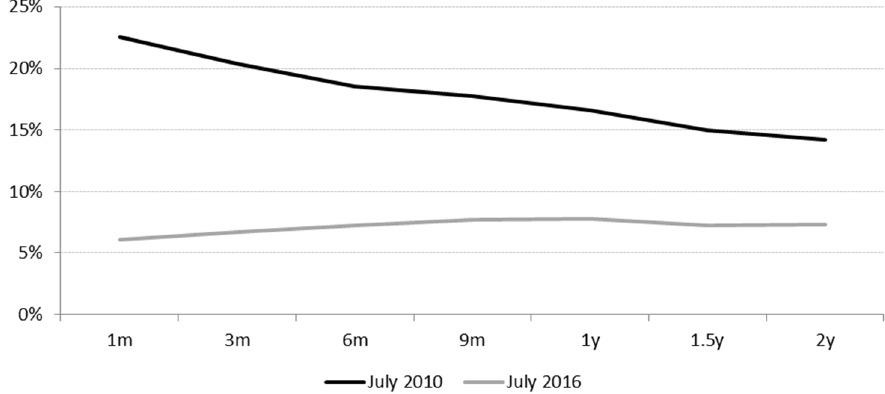
Figure 1. The US equity curve for two days, a typical “normal” curve (July 2016) and a typical “crisis” curve (July 2010).